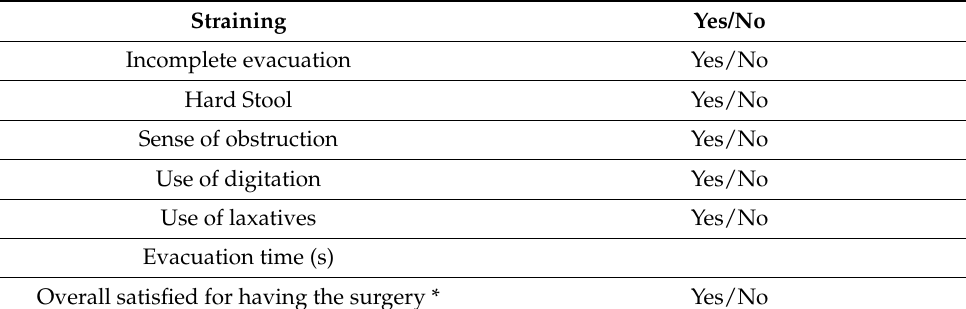
Table A1. Questionnaire used to evaluate obstructed defecation syndrome